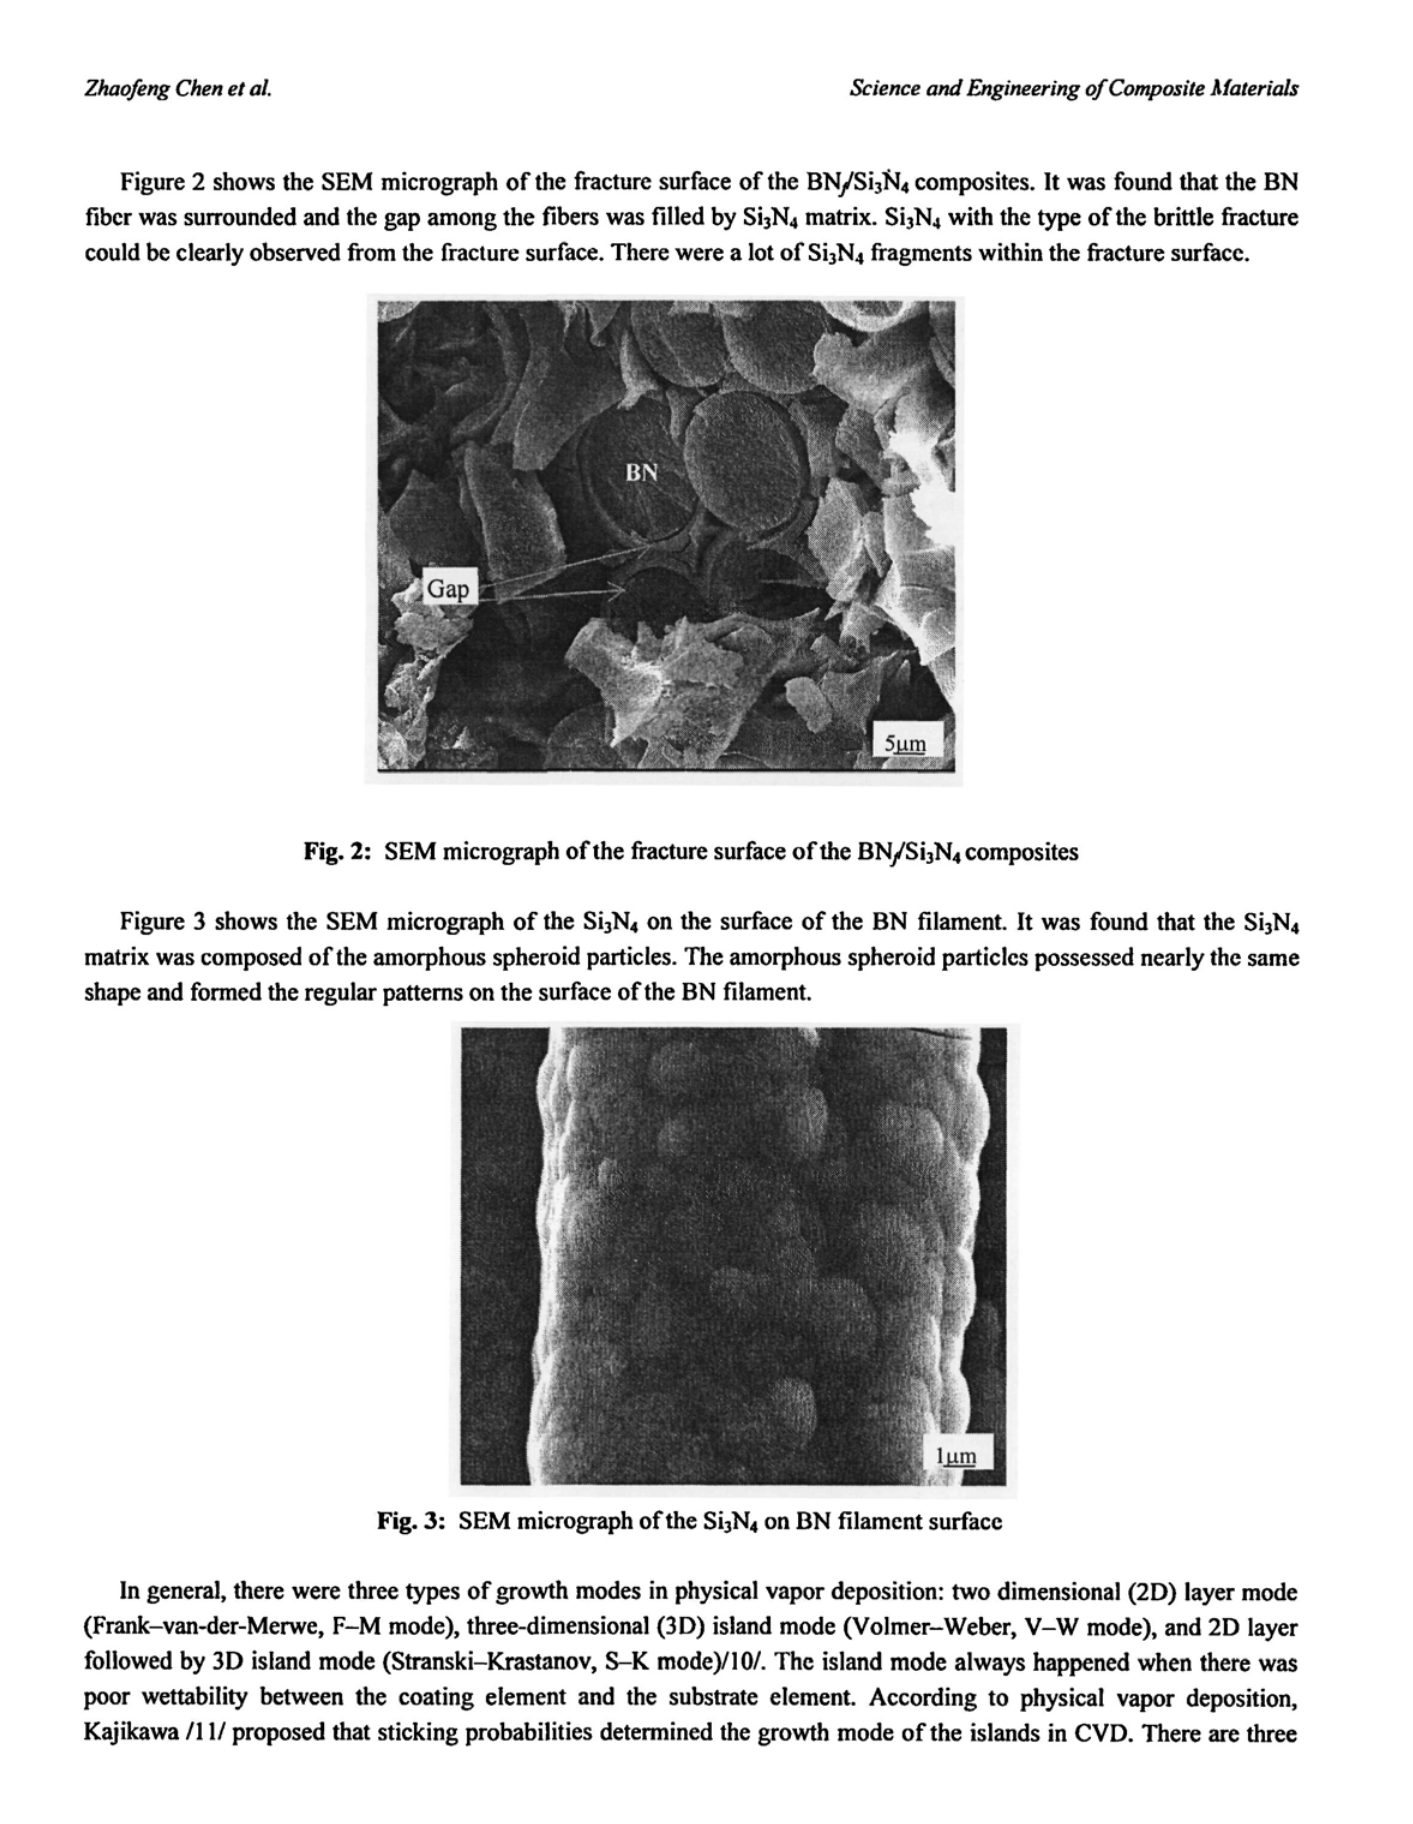
Fig. 3: SEM micrograph of the Si